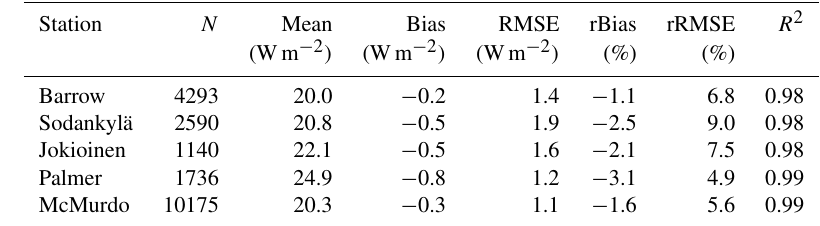
Table 5. Statistical indicators of the performances of the method for UV-A irradiance. N is the number of data points.